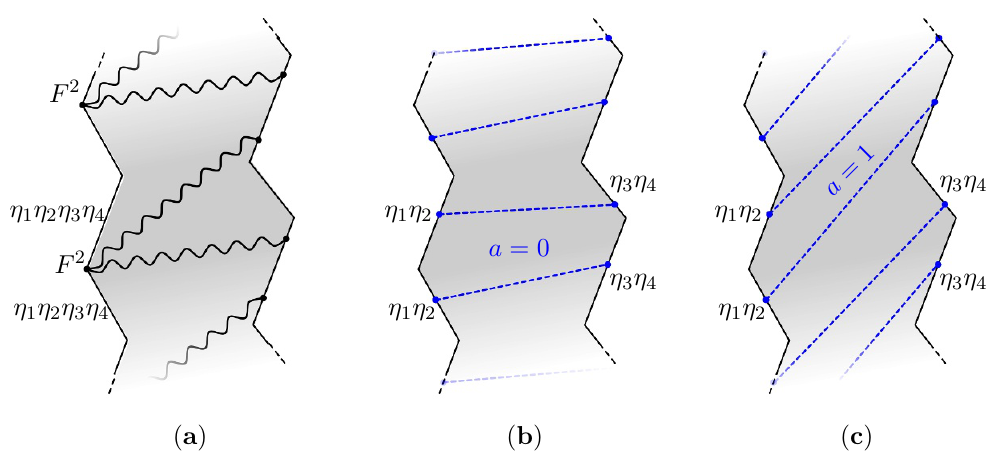
Figure 10 . (a) An example of a gluon contraction that contributes to W 2 ; 2 ( l ) for the parametriza- tion (5.15). On the left line one (cid:12)nds a square of the (cid:12)eld strength component ( F 2 ) inserted at a single cusp (it is not the same as the square of the F component that appears when it is inserted by itself). On the right line one (cid:12)nds two gauge (cid:12)elds that are integrated over an edge. These in- tegrals are intertwined, making it harder to extract the result from known single trace amplitudes. b,c) Two speci(cid:12)c edge-to-edge diagrams in the hybrid component parametrization (5.17). Diagram (b) is related to (c) by a shift of the right line by one period. Diagram (b) can be chosen to